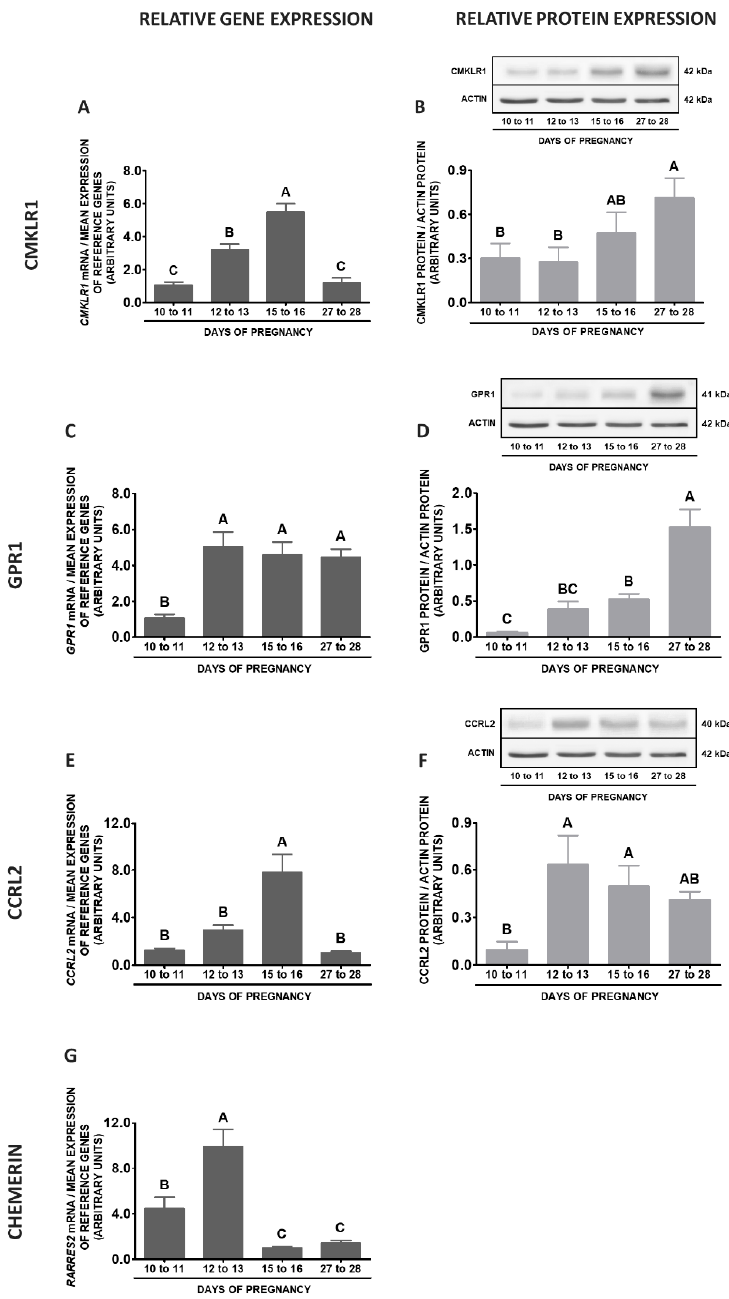
Figure 6. Chemerin system expression in the porcine mediobasal hypothalamus (MBH) during early pregnancy. Gene and protein expression of chemokine-like receptor 1 (CMKLR1; A and B ), G protein-coupled receptor 1 (GPR1; C and D ) and C-C motif chemokine receptor-like 2 (CCRL2; E and F ), as well as chemerin ( RARRES2 ) mRNA content ( G ) in the porcine MBH on days: 10 to 11, 12 to 13, 15 to 16 and 27 to 28 of pregnancy. Gene expression was determined by qPCR. Protein expression was determined by Western blotting; upper panels: representative immunoblots; lower panels: densitometric analysis of CMKLR1/GPR1/CCRL2 proteins relative to actin protein. Representative actin blots are identical for all chemerin receptors though proteins have been analysed on different gels. Results are presented as means ± SEM ( n = 5). Bars with different superscripts differ (one-way ANOVA at p < 0.05 followed by Tuckey post-hoc test at p < 0.05).